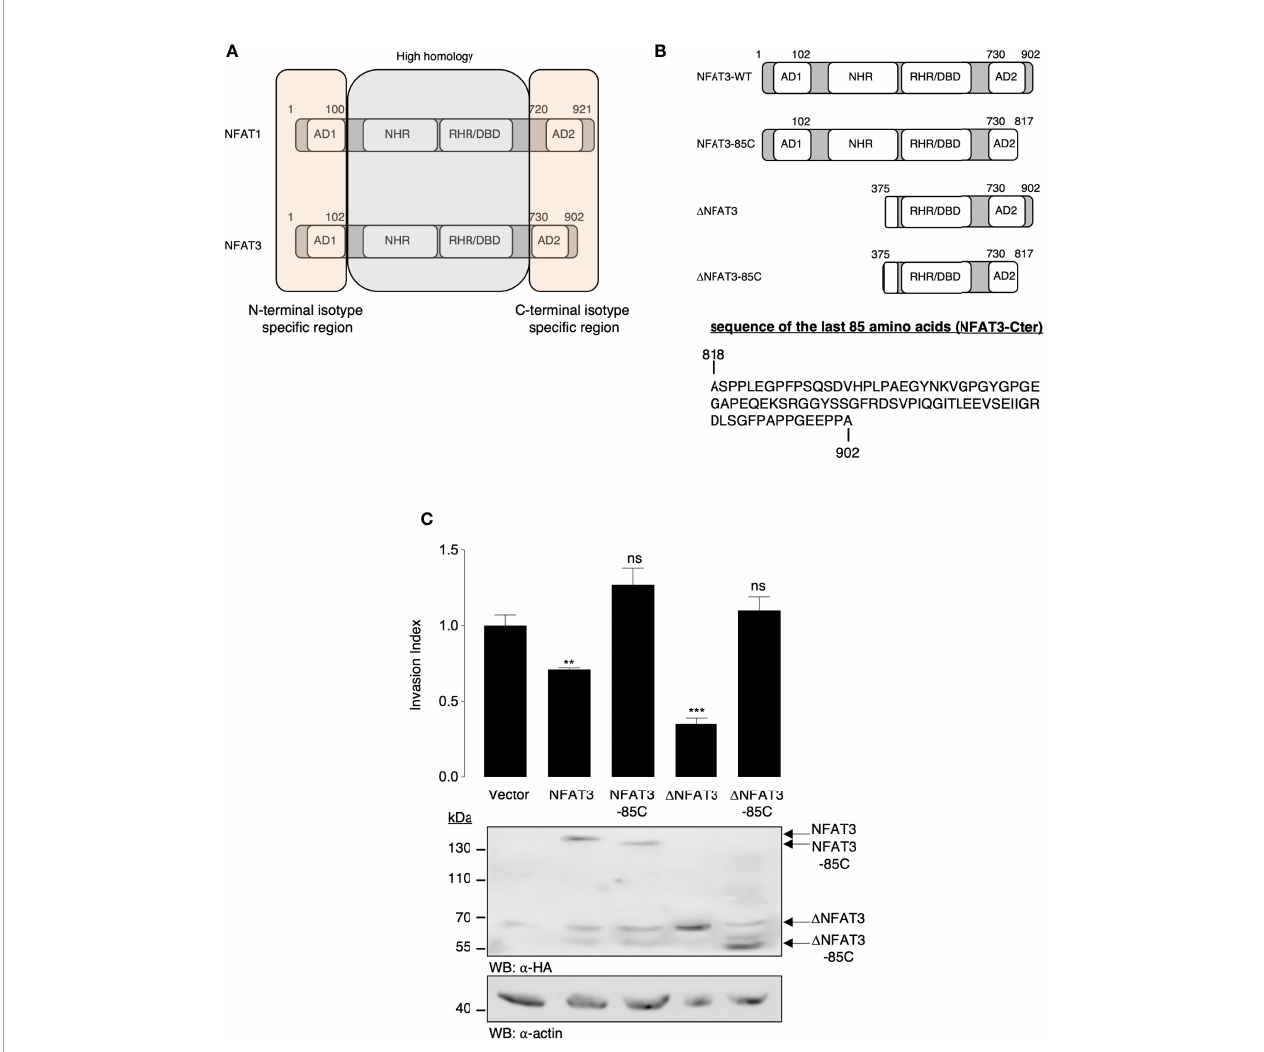
FIGURE 1 | The last 85 C-terminal amino acids of NFAT3 are required for the inhibition of cell invasion. (A) Schematic representation of the homologous and isotype-speci fi c regions of human NFAT1 and NFAT3 with the activation domains (ADs), the NFAT homology domain (NHR), the Rel homology domain (RHR), and the DNA-binding domain (DBD). (B) Schematic representation of the NFAT3, NFAT3-85C, D NFAT3, and D NFAT3-85C constructs used in the study and the sequence of the last 85 amino acids of NFAT3 (NFAT3-Cter). (C) T-47D cells were transiently transfected with either a vector encoding the HA epitope fused to NFAT3, NFAT3-85C, D NFAT3, or D NFAT3-85C or with the empty vector (Vector). The following day, transfected cells were subjected to an in vitro invasion assay for 24 h. All data are shown as the mean of two independent experiments ± SEM (n=2 biological replicates; 3 technical replicates for each experiment, **p<0.005, ***p< 0.0001, ns, non speci fi c relative to the vector-transfected cells). Whole cell lysates were revealed by a -HA and normalized by revelation with an a